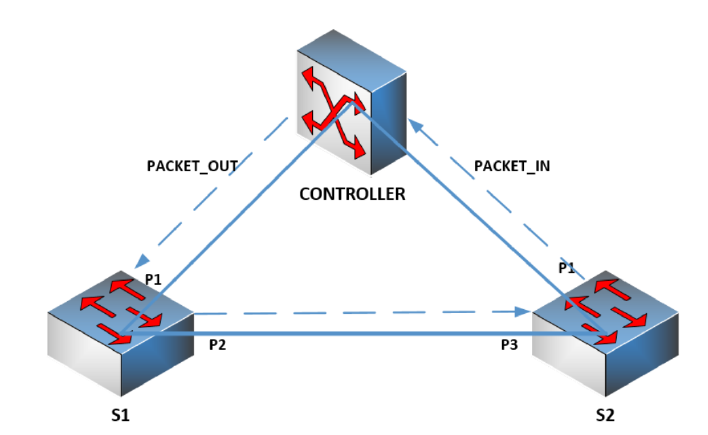
Figure 5. Link discovery